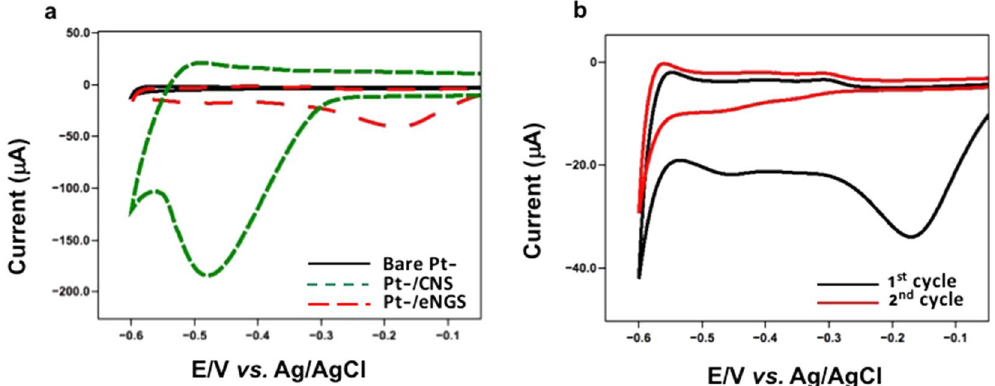
Figure 1. ( a ) Electrochemical synthesis of eNGS, and ( b ) Irreversible electrochemical reduction of eNGS in PBS (pH 4.5/saturated with N 2 gas). Scan rate - 20